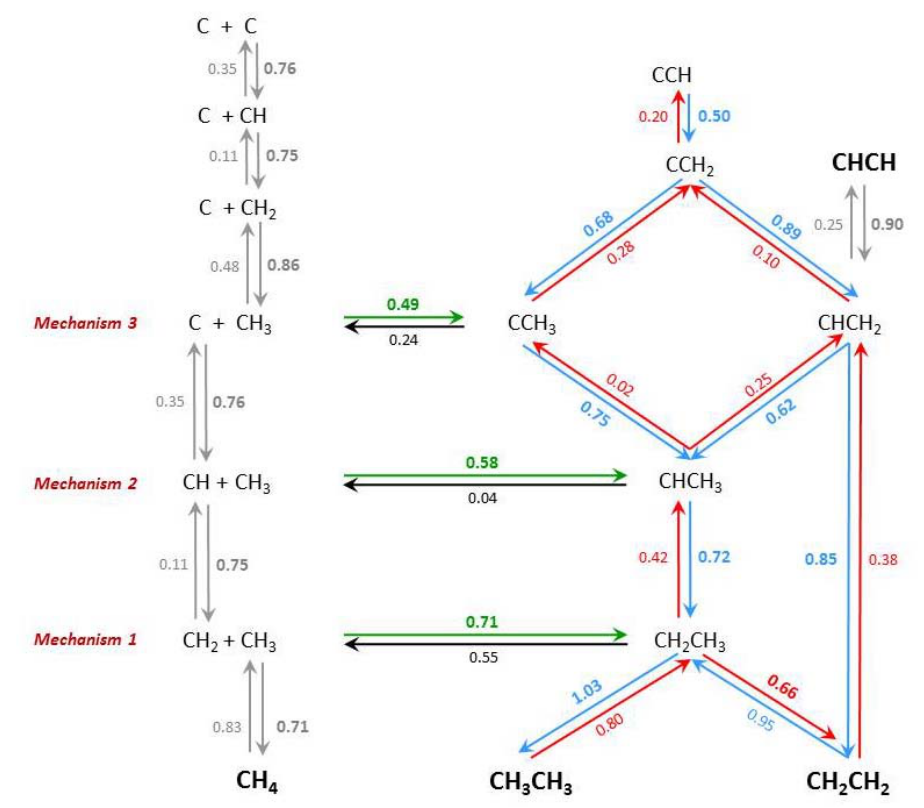
Figure 4. Comprehensive diagram describing a selection of surface reactions of C on Fe(100); the selection considers barriers below 1 eV for C-C bond formation